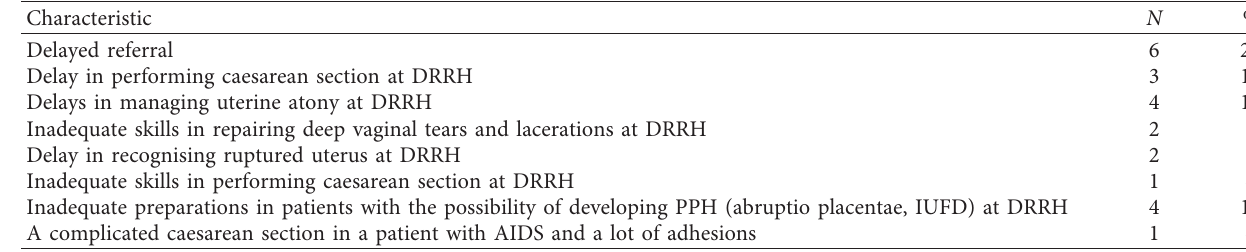
Table 4: Contributing factors to the deaths ( N �